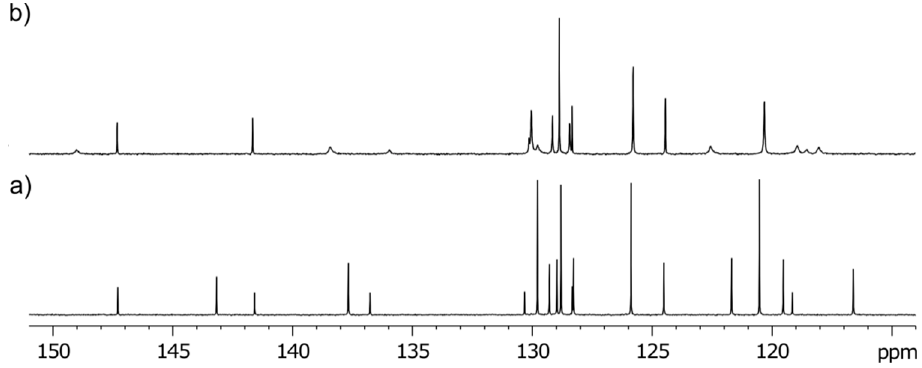
Figure 4. Aromatic region of 13 C NMR spectra of: ( a ) 2b in CDCl 3 , and ( b ) a mixture of 2b (42 mM) and [RuCl( μ -Cl)( η 6 - p -cymene)] 2 (21 mM) in CDCl 3 .